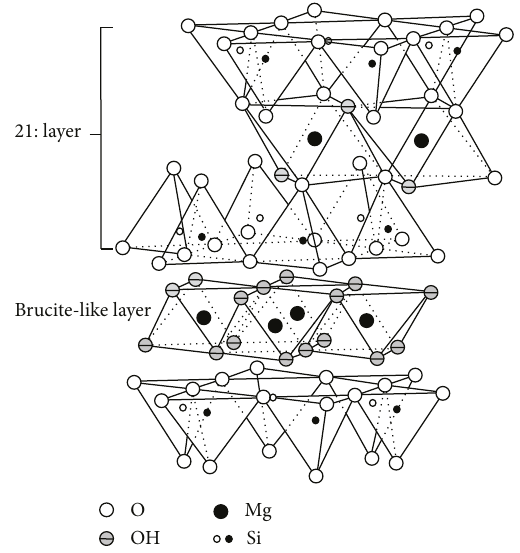
Figure 1: The structure of chlorite. Brucite-like and 2 :1 layers are contained in the